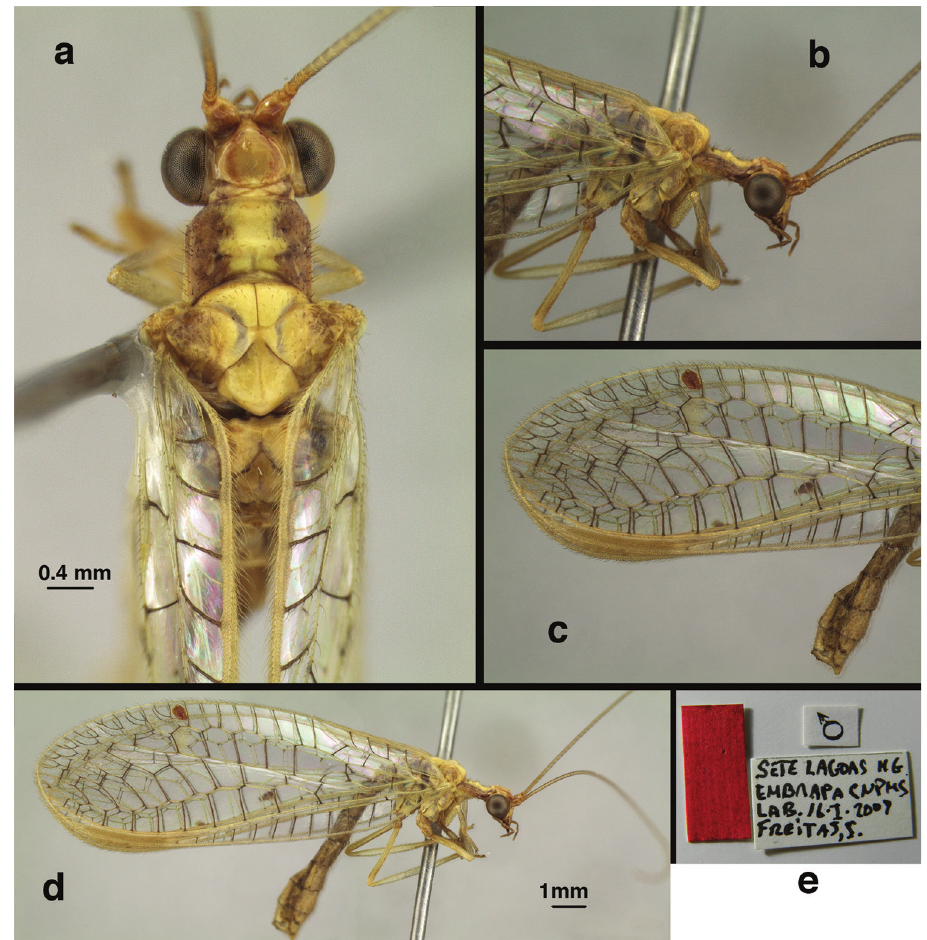
Figure 134. Ungla ivancruzi Freitas: External features, ( a ) head, thorax, dorsal ( b ) head, thorax, lateral ( c ) tip of wings and abdomen, lateral ( d ) body, lateral ( e ) labels (Brazil, Minas Gerais, holotype, male, SFC; images FS). wide (ratio, L : W = 2.9 : 1); height of tallest costal cell 0.63 mm (cell number 5); width of first intramedian cell 0.65 mm; 9 radial cells (closed cells between R and Rs); third gradate cell 0.9 mm long, 0.4 mm wide (ratio, L : W = 2.3 : 1); fourth gradate 0.4 mm long, 0.3 mm wide (ratio, L : W = 1.5 : 1); 4 Banksian cells (b cells), 4 b’ cells; 3 inner gradates, 5 outer gradates. Hindwing 7.2–9.2 mm long, 3.0 mm wide (ratio, L : W = 3.0 : 1), 9-11 radial cells, 3 Banksian (b) cells, 4 b’ cells, 3 inner gradates, 5 outer gradates. Abdomen yellowish green, without spots. Male. T9+ect relatively long (~0.5 length of T7), almost straight dorsally, angulate at dorsal terminus, with dorsal invagi- nation deep (~0.7× dorsal length of T9+ect); margins, base of invagination rounded; abdominal spiracles small (e.g., A7: spiracle diameter ~0.09× length of sternite);